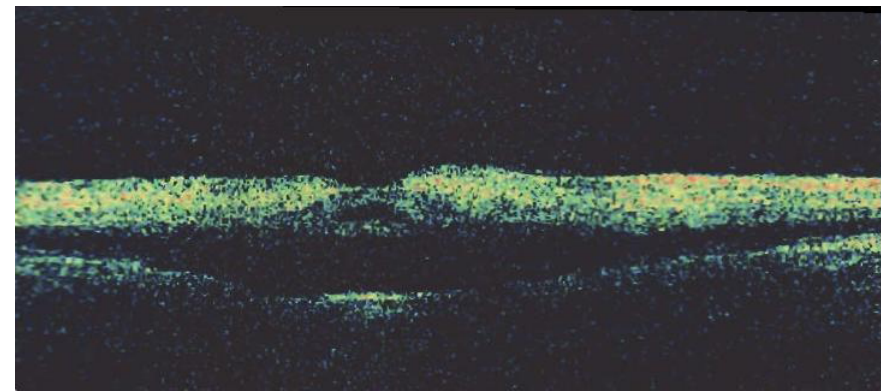
Figure 5: OCT of the right